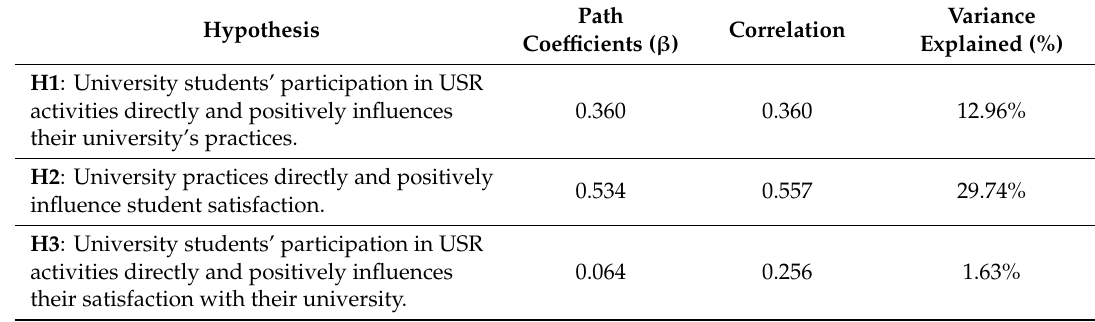
Table 8. Contribution of predictive constructs to variance explained.